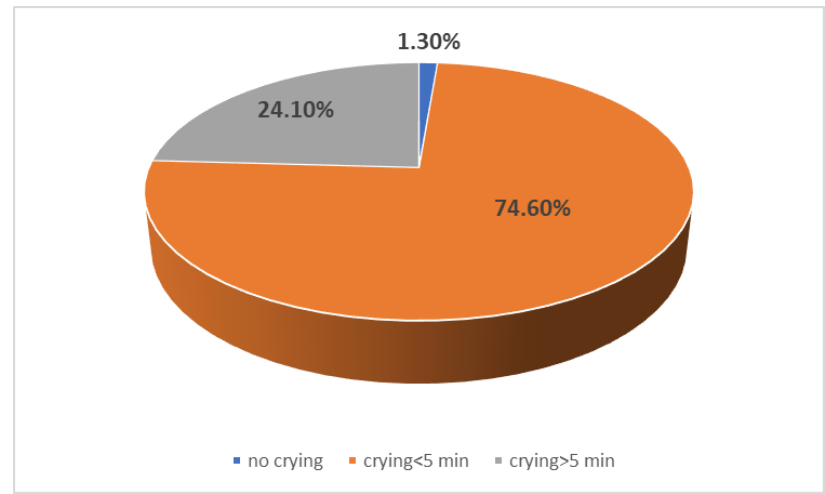
Figure 2. Distribution of patients according to duration of calming down.